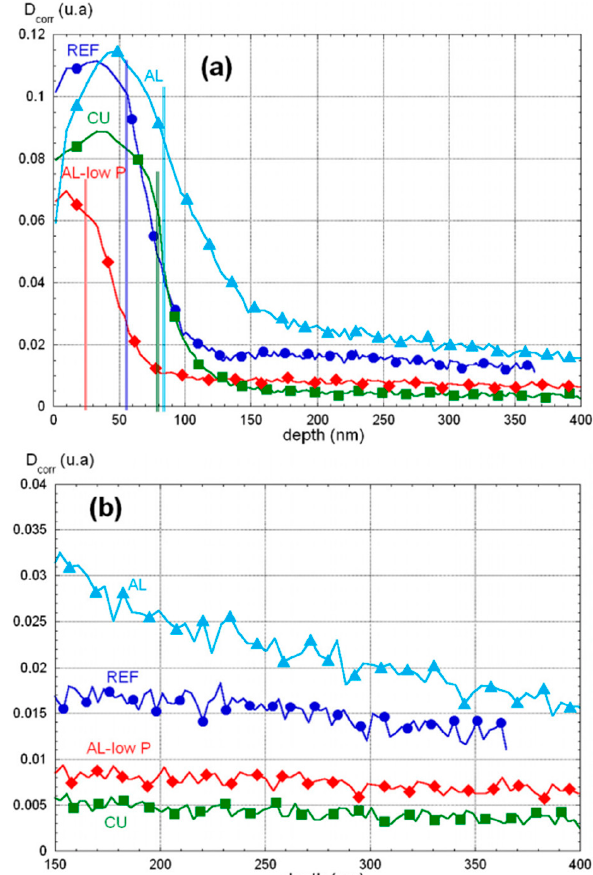
Figure 14. Weight loss versus time for Fe-18Mn-0.6C-0.032P exposed to 5 wt.% NaCl [98]. (Repro- duced with permission from refs. [98] . Copyright (2014 ), Elsevier).